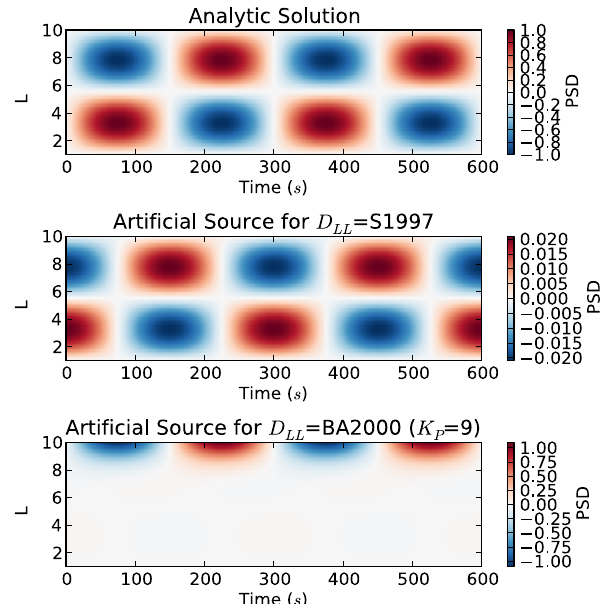
Fig. 3. Behavior of the manufactured solution (top frame), Q MMS when S1997 D LL is employed (center frame), and Q MMS when BA2000 D LL ( Kp = 9 ) is used (bottom frame). Following Eq. (8), for a smaller α factor, the source closely resembles the analytic so- lution, but scaled and phase-shifted (center frame). As α becomes stronger, the source becomes more complicated to counteract the strong diffusion at high L (bottom